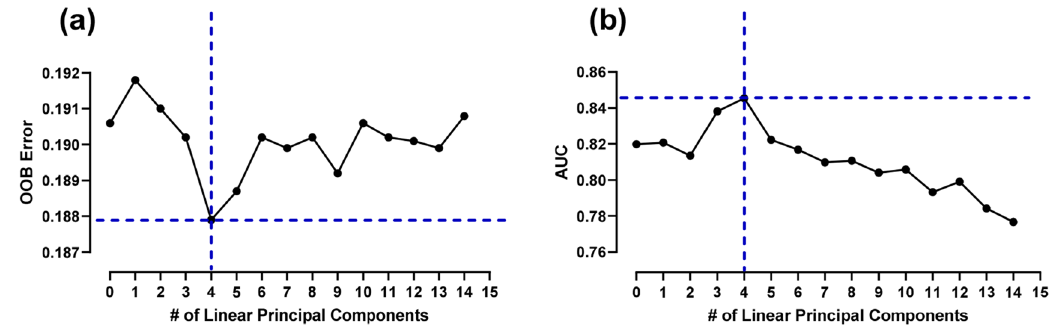
Figure 2. ( a ) OOB error is lowest when 4 linear features are added to model developed using nonlinear gait variables and ( b ) AUC is highest when 4 features are added to the nonlinear variable RF model.